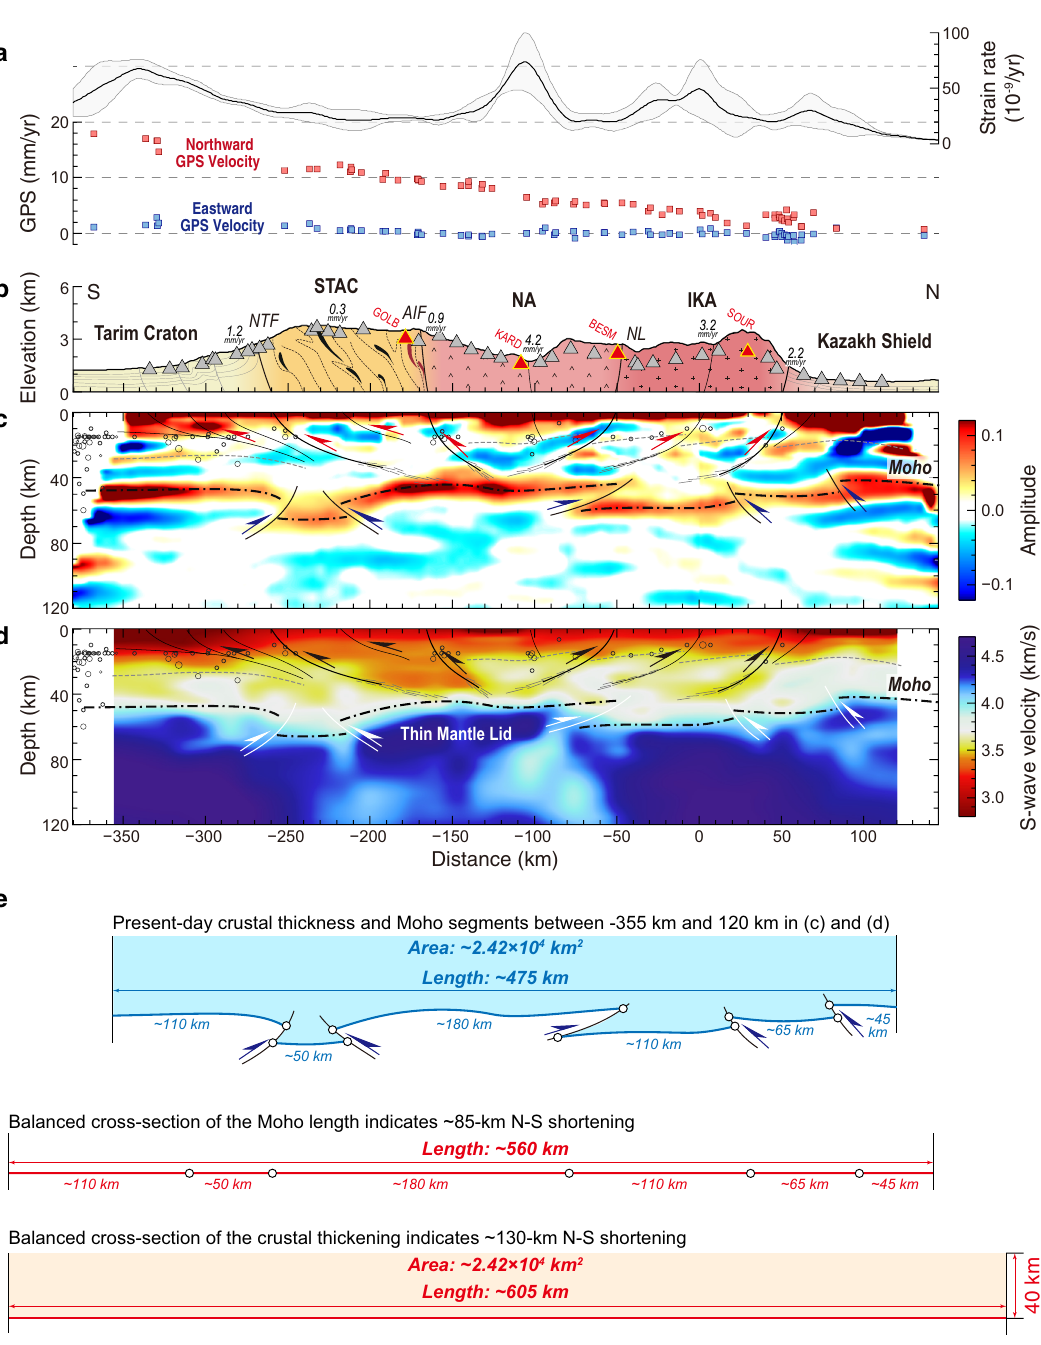
Fig. 2 Interpreted seismic images and balanced cross-sections across the central Tianshan. a Strain rates 37 and GPS velocities 70 along the cross-section. The bold black line and gray- fi lled area indicate the averaged strain rates and corresponding standard deviations within a 1.0-degree width corridor centered by the cross-section. The individual GPS observations within the corridor are projected onto the cross-section as blue squares for eastward components and red squares for northward components. b Schematic geological cross-section across the Tianshan showing major tectonic units (modi fi ed after Xiao et al. 4 ) and the slip rates of main faults 28,69 . Triangles represent stations used in this study, and red ones with marks indicate four stations chosen as examples showing the joint inversion in Supplementary Figs. 4 and 5. AIF Atbashy-Inylchek Fault, IKA Issyk Kul Arc, NA Naryn Arc, NL Nikolaev Line, NTF North Tarim Fault, STAC South Tianshan Accretionary Complex. c , d The CCP stacking image with a Gaussian coef fi cient of 2.0 and the V S model were obtained from joint inversion in this study. These are plotted with interpreted faults (solid lines), Conrad (dashed thin lines) and Moho (dashed thick lines) discontinuities. Gray circles denote earthquakes located within a 50-km width corridor centered by the cross-section 65 . e Estimates of N – S shortening in the Tianshan based on the balanced cross-sections of the Moho length and crustal